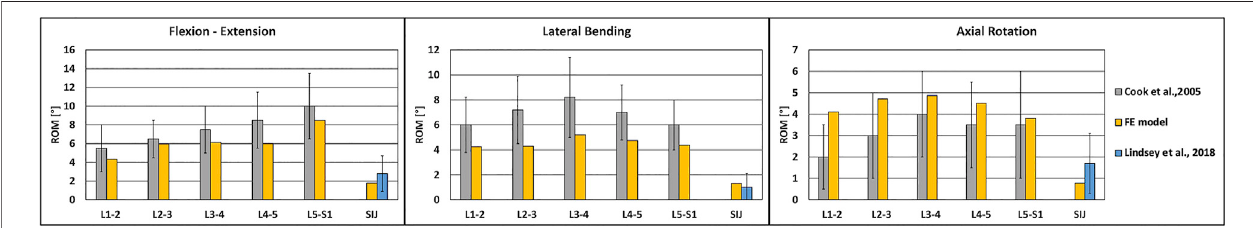
FIGURE2| ValidationoftheintactFEmodelundersimpli fi edloadingconditions.PredictedrangesofmotionofL1-S1andsacroiliacjointsoftheintactmodelunder simpli fi ed loading conditions in fl exion-extension (left), lateral bending (middle) and axial rotation (right), as compared with data from in vitro experiments, shown as mean and standard deviation (Cook et al., 2015; Lindsey et al., 2018).